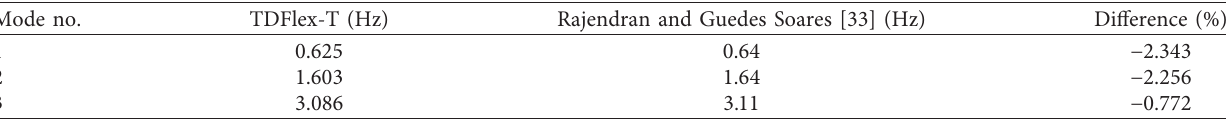
Table 4: Dry natural frequencies of the LCS for vertical flexural vibrations.